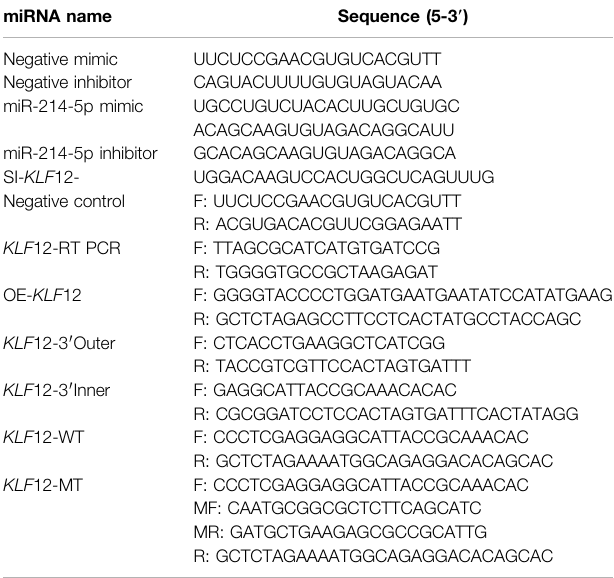
TABLE 1 | Sequence of miR-214-5p mimics and